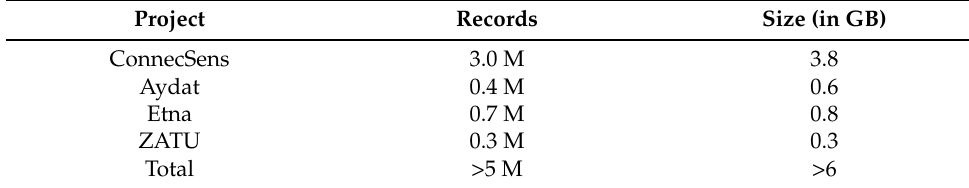
Table 1. Table describing the number of records and the size in the database.